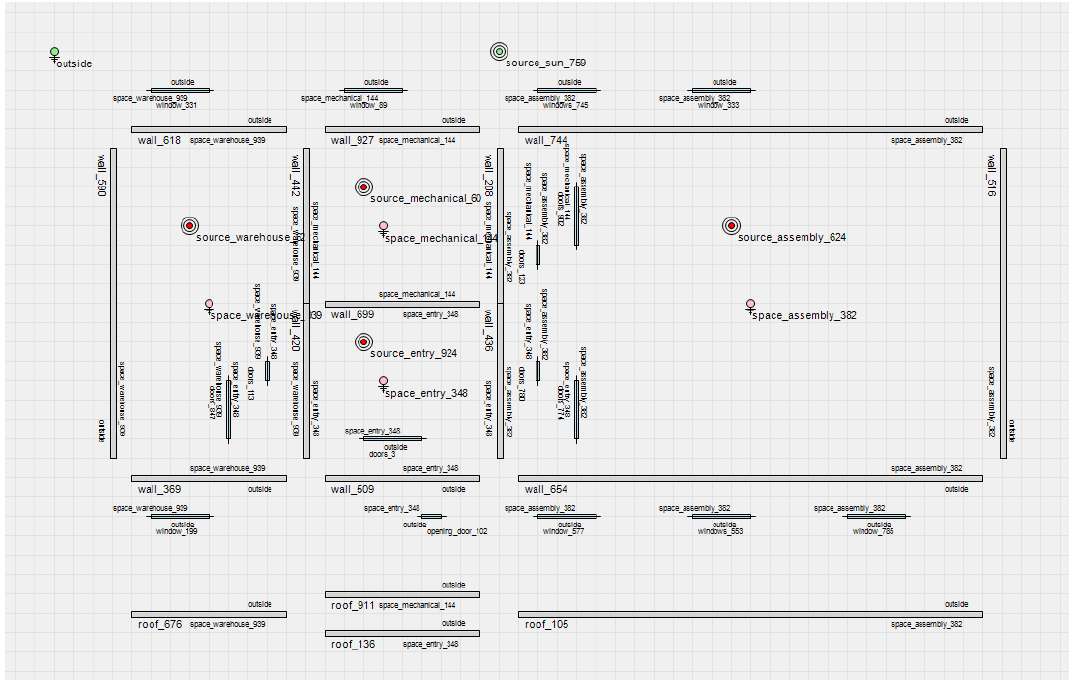
Figure 8. Developing a model structure in ModelBuilder application.